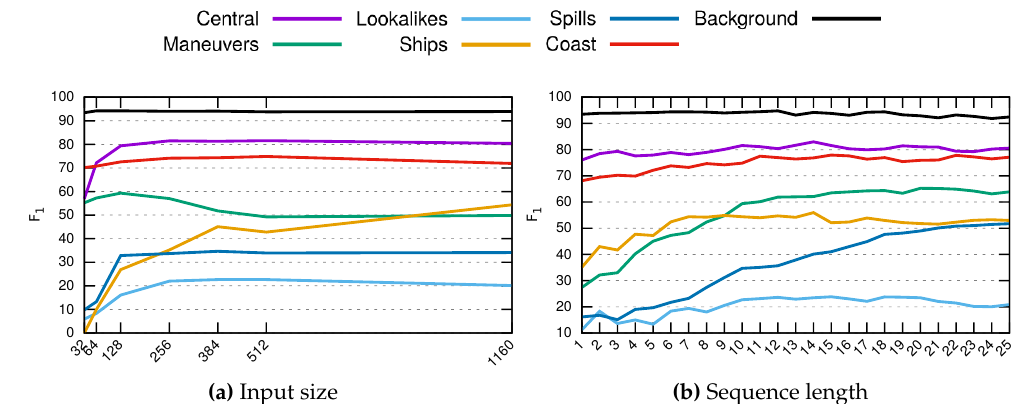
Figure 6. Comparison of the result obtained for each of the classes when varying: ( a ) The input size of the CMSAE networks and ( b ) the number of scanlines used as input. See Table 5 for standard deviation of results based on the settings shown in Table